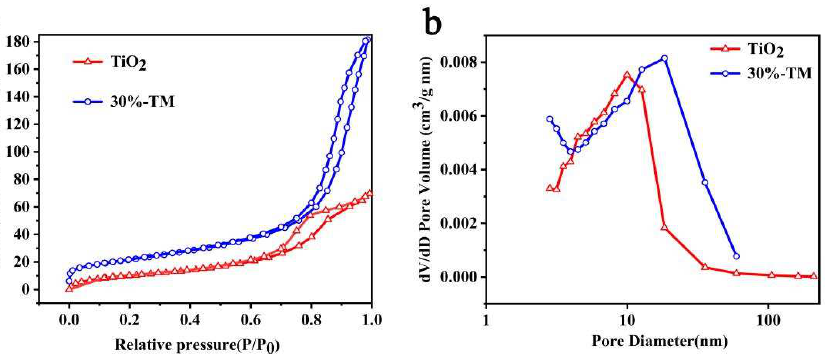
Figure 11. ( a ) Nitrogen adsorption–desorption isotherms of TiO 2 and 30%-TM and ( b ) the pore size distribution of TiO 2 and 30%-TM. Table 3. BET parameters of TiO 2 and